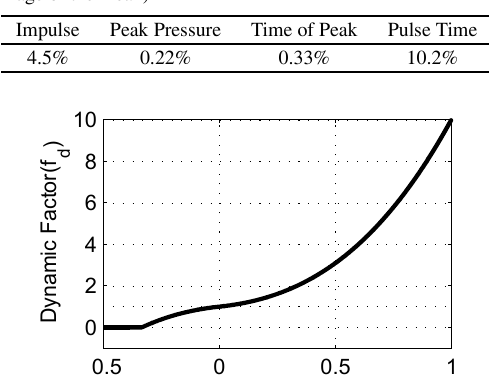
Fig. 11. Dynamic factor resulting from least squares fi t